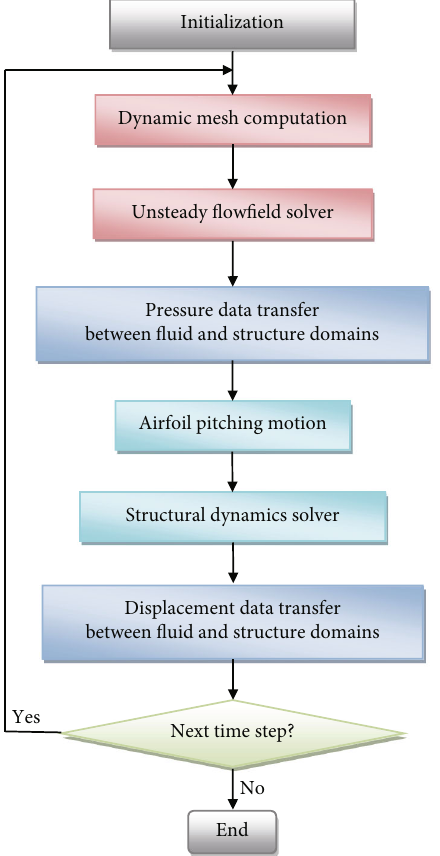
Figure 6: Fluid-structure interaction